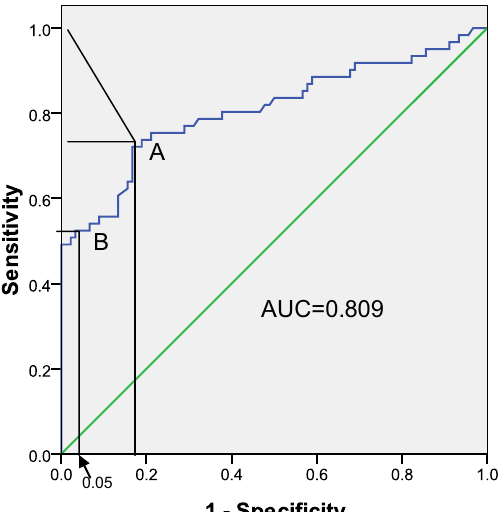
Figure 4. ROC analysis of tumor marker index (TMI) for the diagnosis and screening of gastric cancer. ( A ) optimum cut-off value for diagnosis (incidence = 0.50); ( B ) optimum cut-off value for screening (incidence = 0.05).